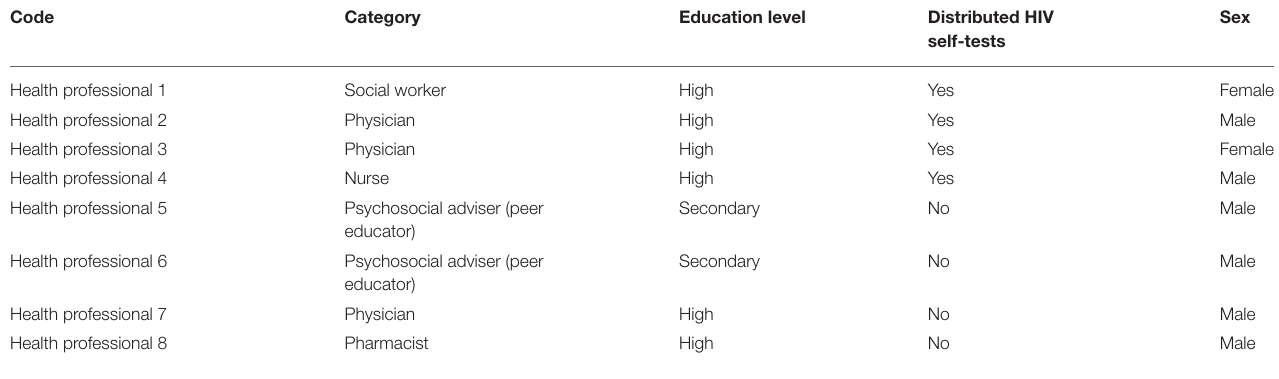
TABLE 1 | Profile of the health professionals, including peer educators, who participated in the